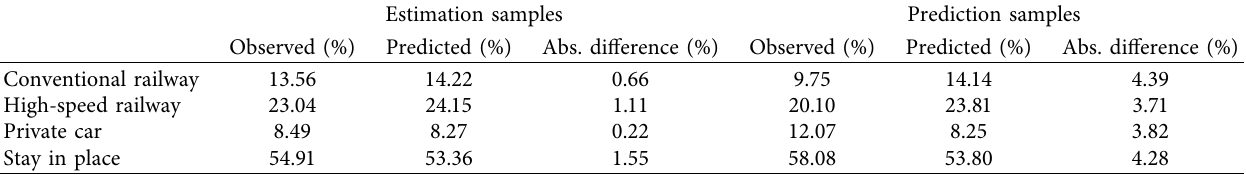
Table 4: Predictions for estimation and prediction samples using the fnal model. Estimation samples